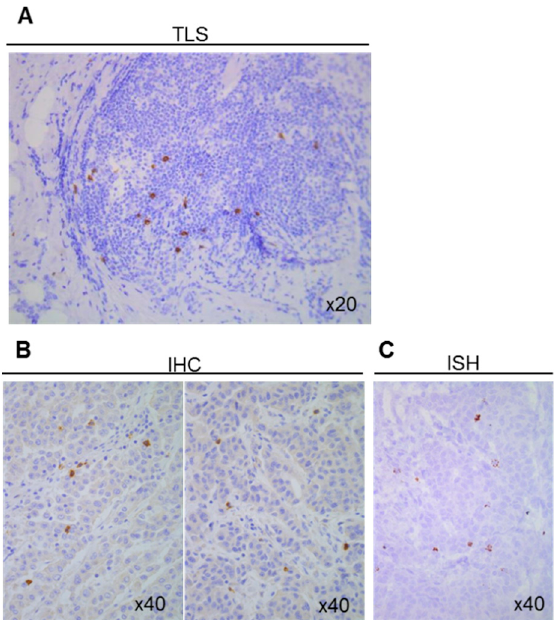
Figure 1. Detection of γδ T-cells using the H-41 antibody. ( A ) Detection of γδ T-cells by immunohistochemistry in a tertiary lymphoid structure (TLS) located close to a breast tumor. Detection of γδ T-cells in colon cancer sections by ( B ) immunohistochemistry (IHC) and ( C ) in situ hybridization (ISH).